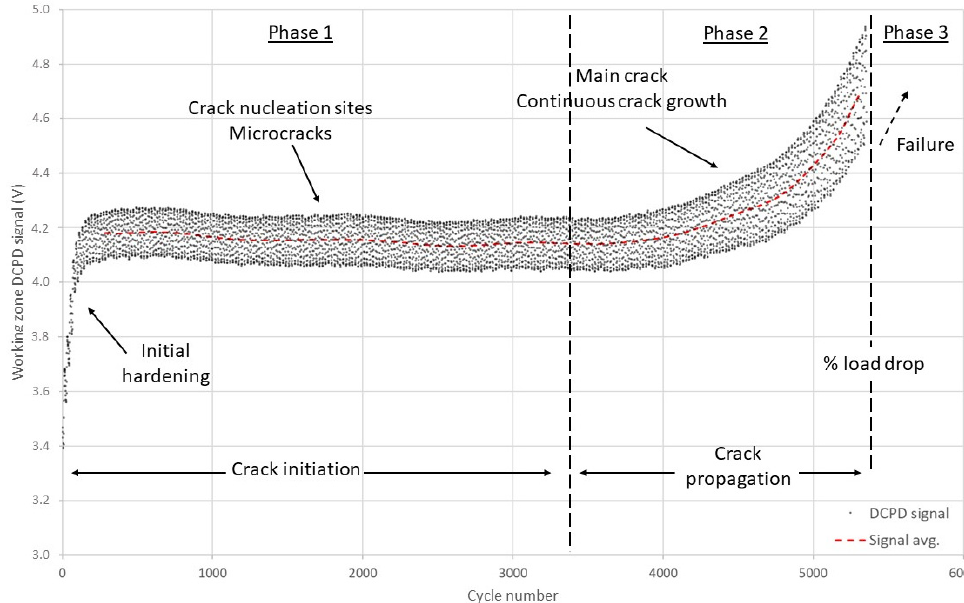
Figure 3. Evolution of DCPD signal in an EAF test and different crack regions.